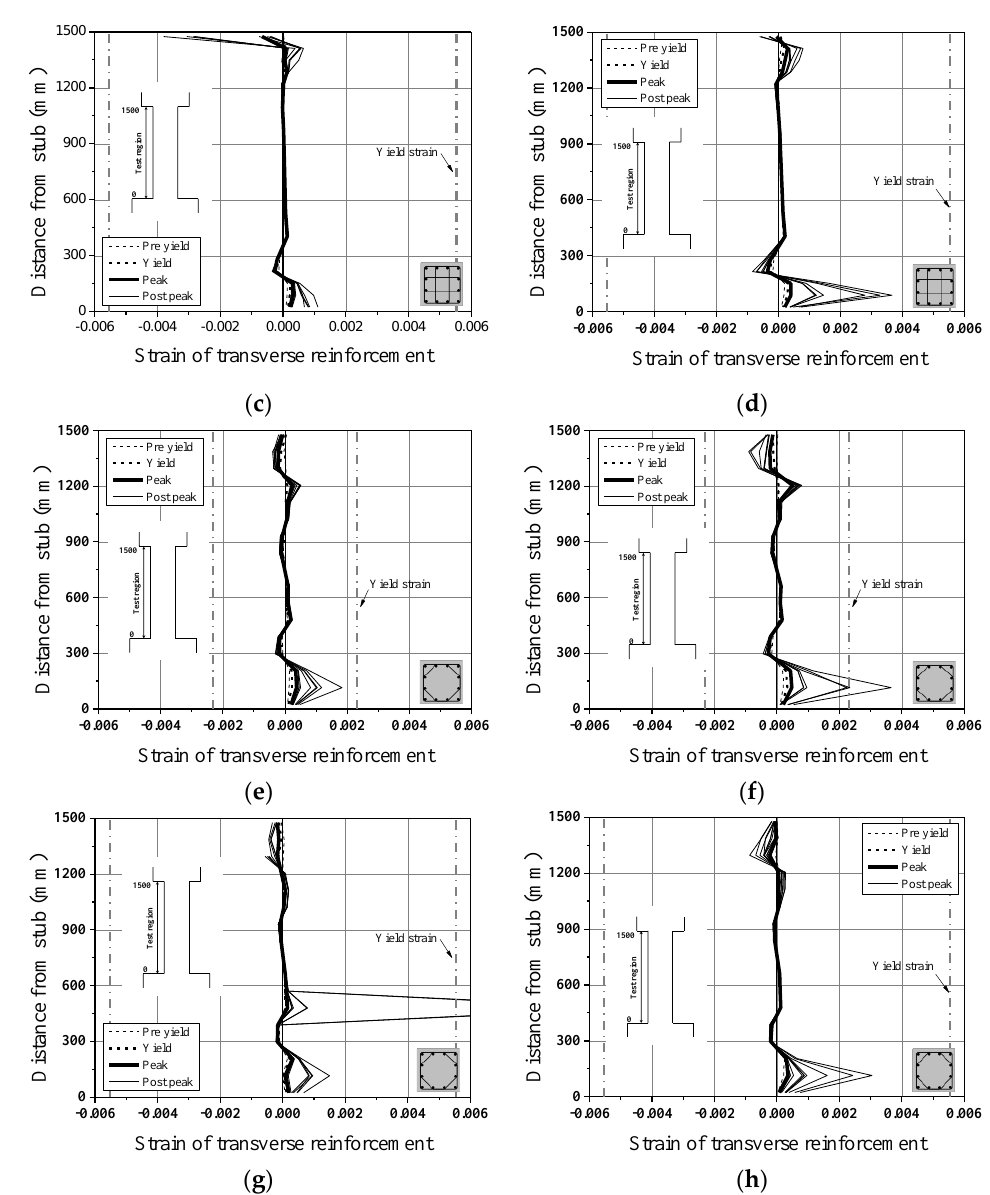
Figure 8. Strain distributions of transverse reinforcement: ( a ) NH20; ( b ) NH30; ( c ) UH20; ( d ) UH30; ( e ) NS20; ( f ) NS30; ( g ) US20; ( h )